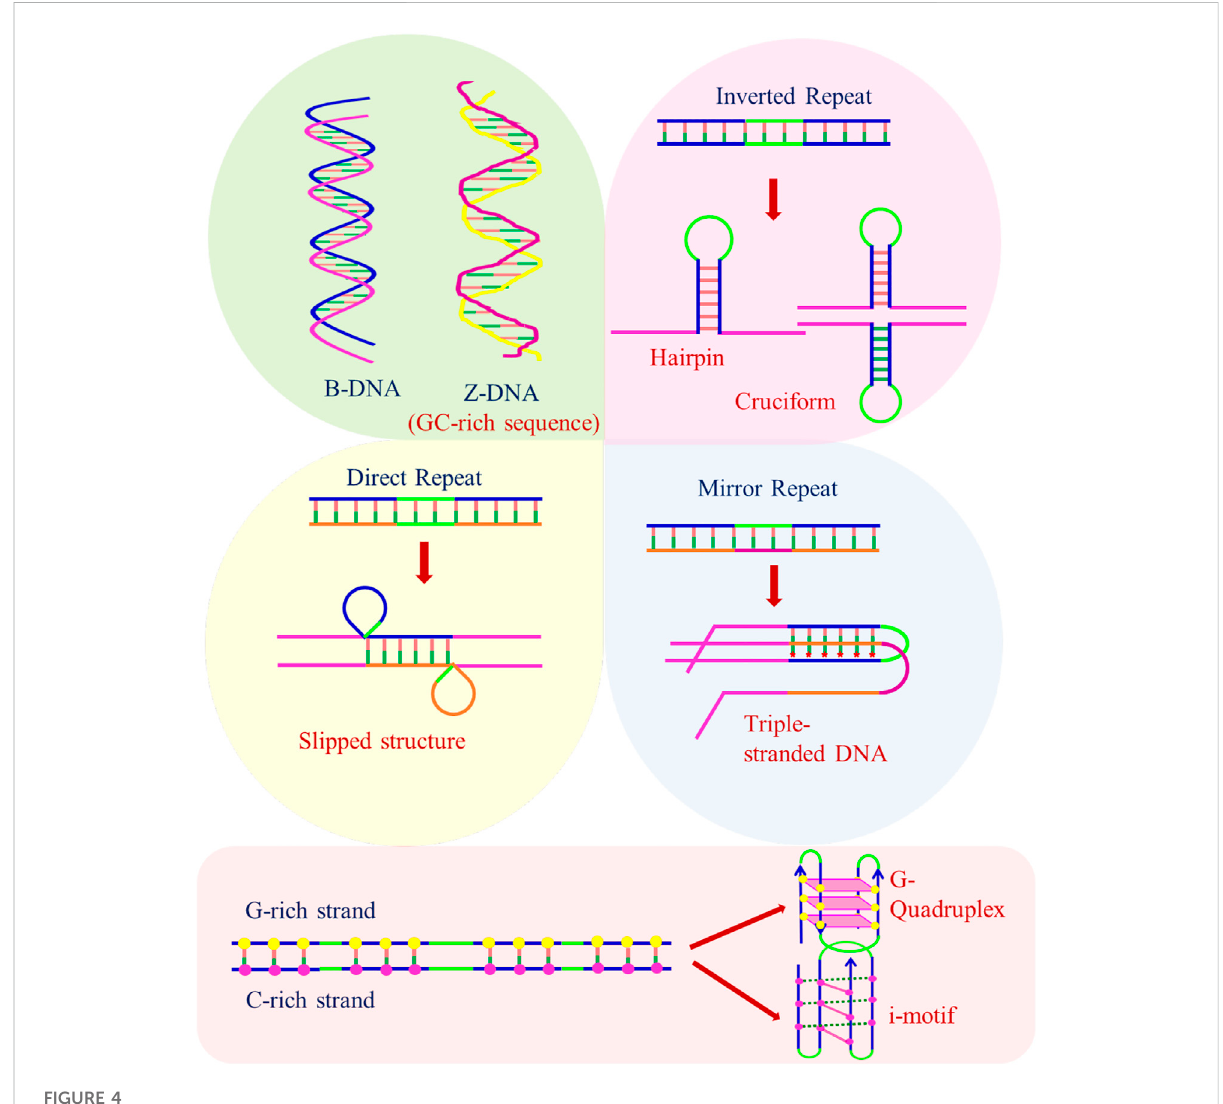
FIGURE 4 Structure of B-DNA and